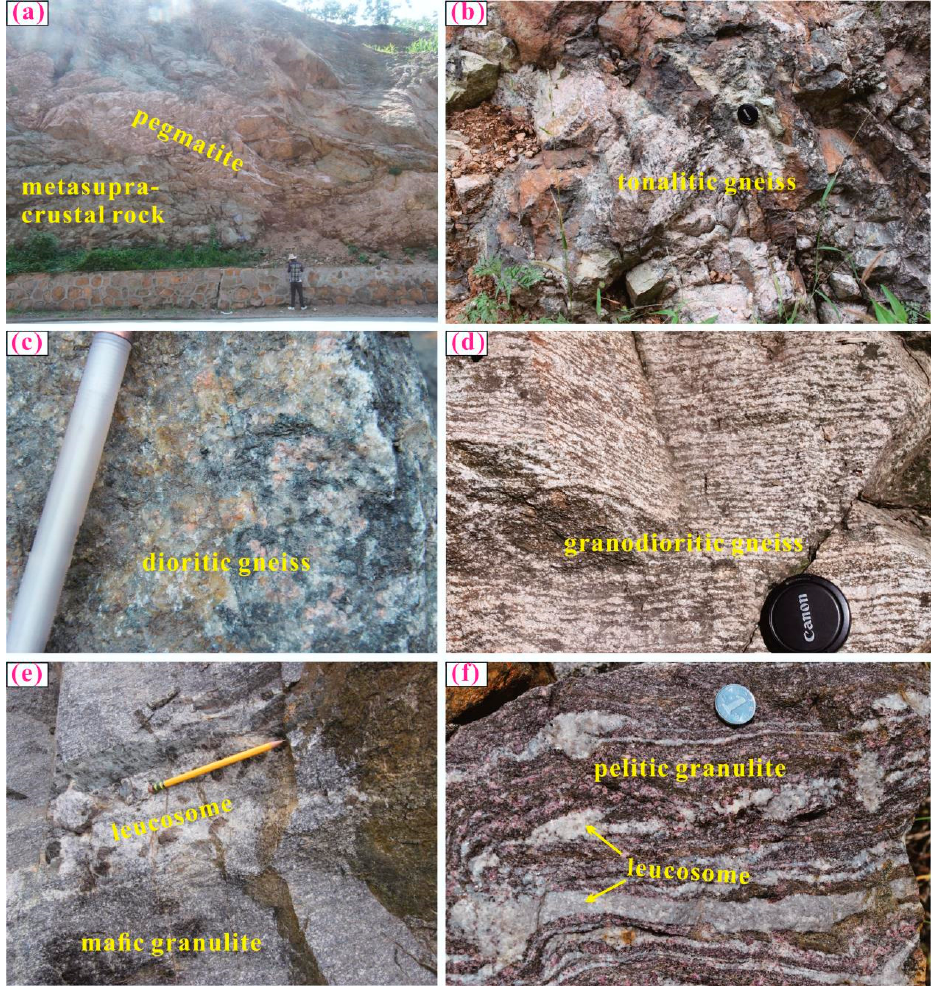
Figure 2. Field photographs of the representative rocks from Eastern Hebei. ( a ) metasupracrustal rocks intruded by syenogranitic pegmatite; ( b ) tonalitic gneiss, showing inhomogeneous petrological feature with melanocratic and leucocratic domains distributed randomly; ( c ) dioritic gneiss; ( d ) gran- odioritic gneiss; ( e ) mafic granulite and leucosome generated during granulite facies metamorphism; ( f ) pelitic granulite with felsic vein formed by partial